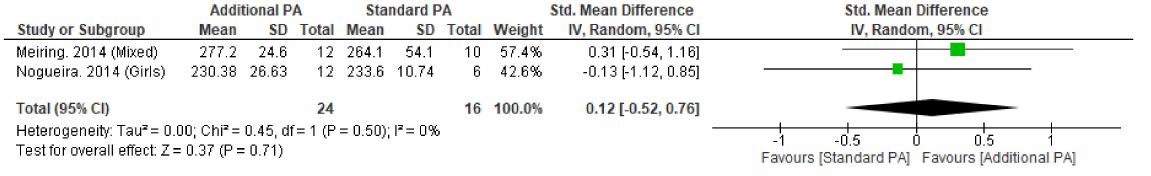
Figure A3. Effect of additional exercise interventions on trabecular bone mineral density within the Tibia (4%) at less than 12 months follow-up. Legend: PA = Physical Activity, Std = standardised, IV = inverse variance, SD- standard deviation, CI = confidence interval.